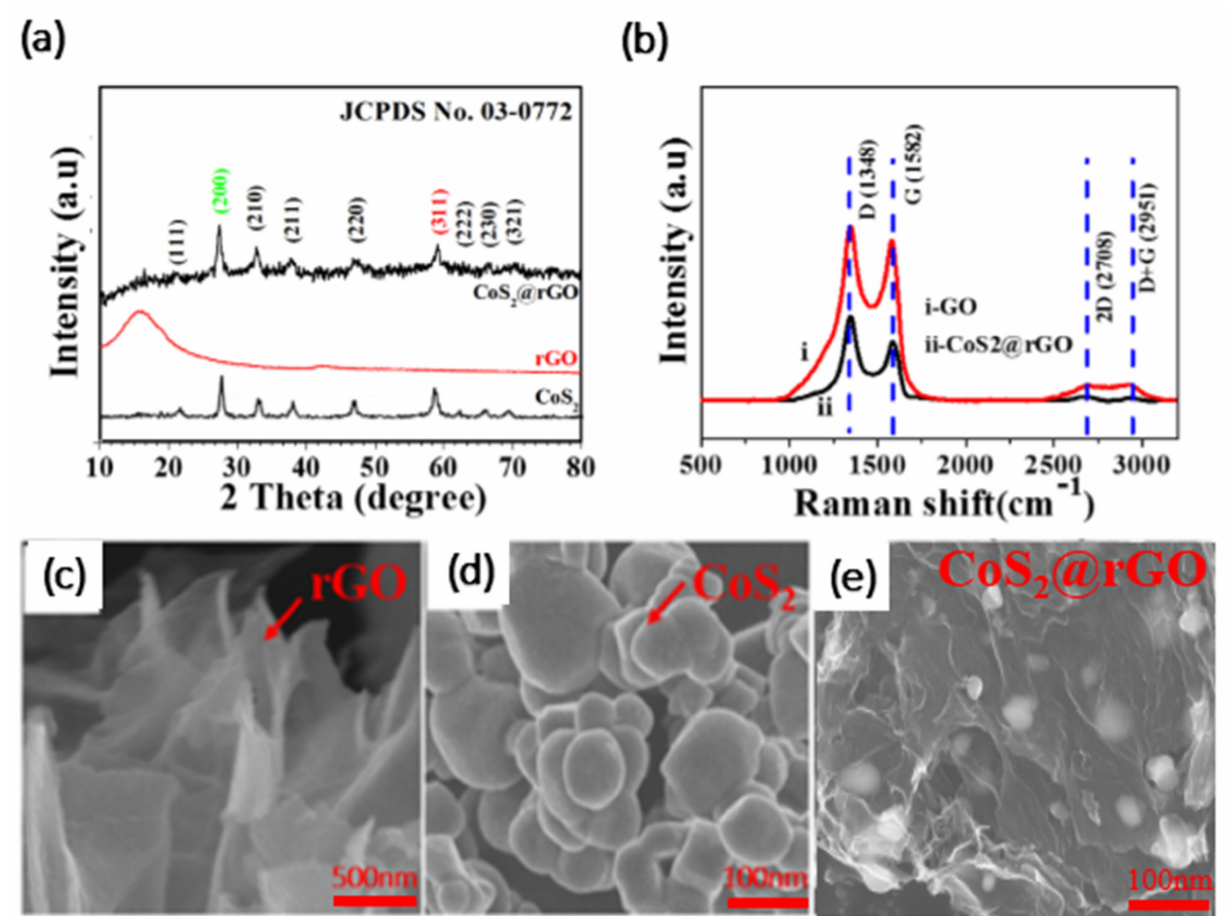
Figure 3. ( a ) XRD pattern and ( b ) Raman spectra of CoS 2 @rGO; ( c – e ) SEM images of rGO, CoS 2 , CoS 2